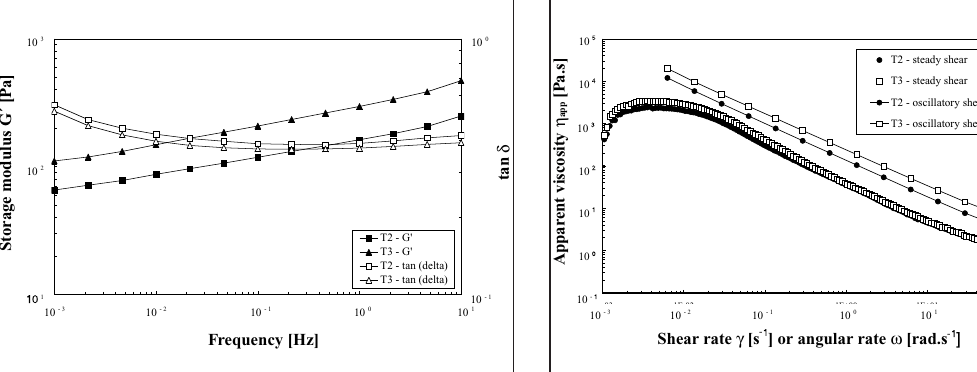
Figure 5 (left): Storage and loss moduli for T2 and T3 yoghurt samples. Figure 6 (right): Cox-Merz diagram of T2 and T3 yoghurt samples.